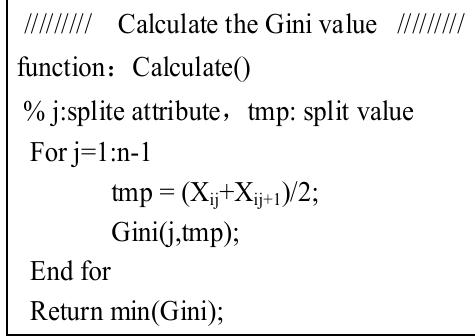
Figure 8. The pseudo code to calculate Gini value.